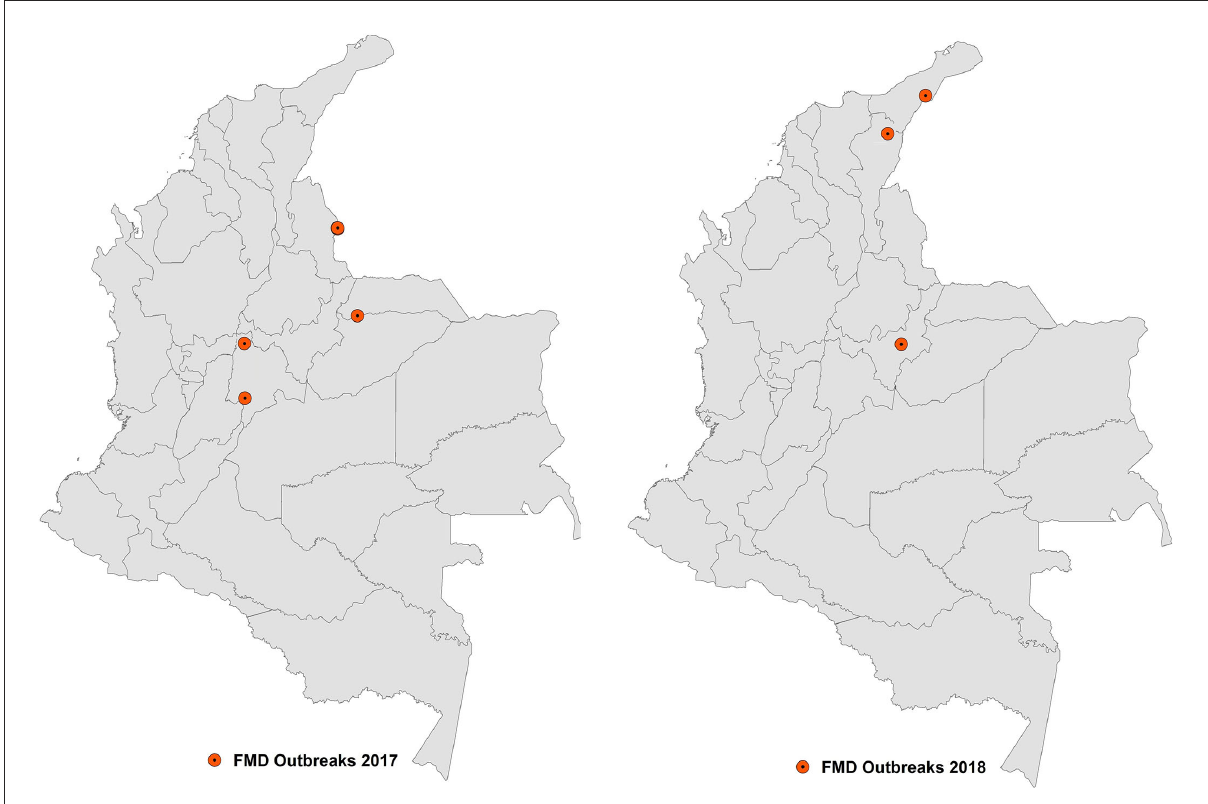
FIGURE4 Location of the FMD outbreaks in Colombia in 2017 and